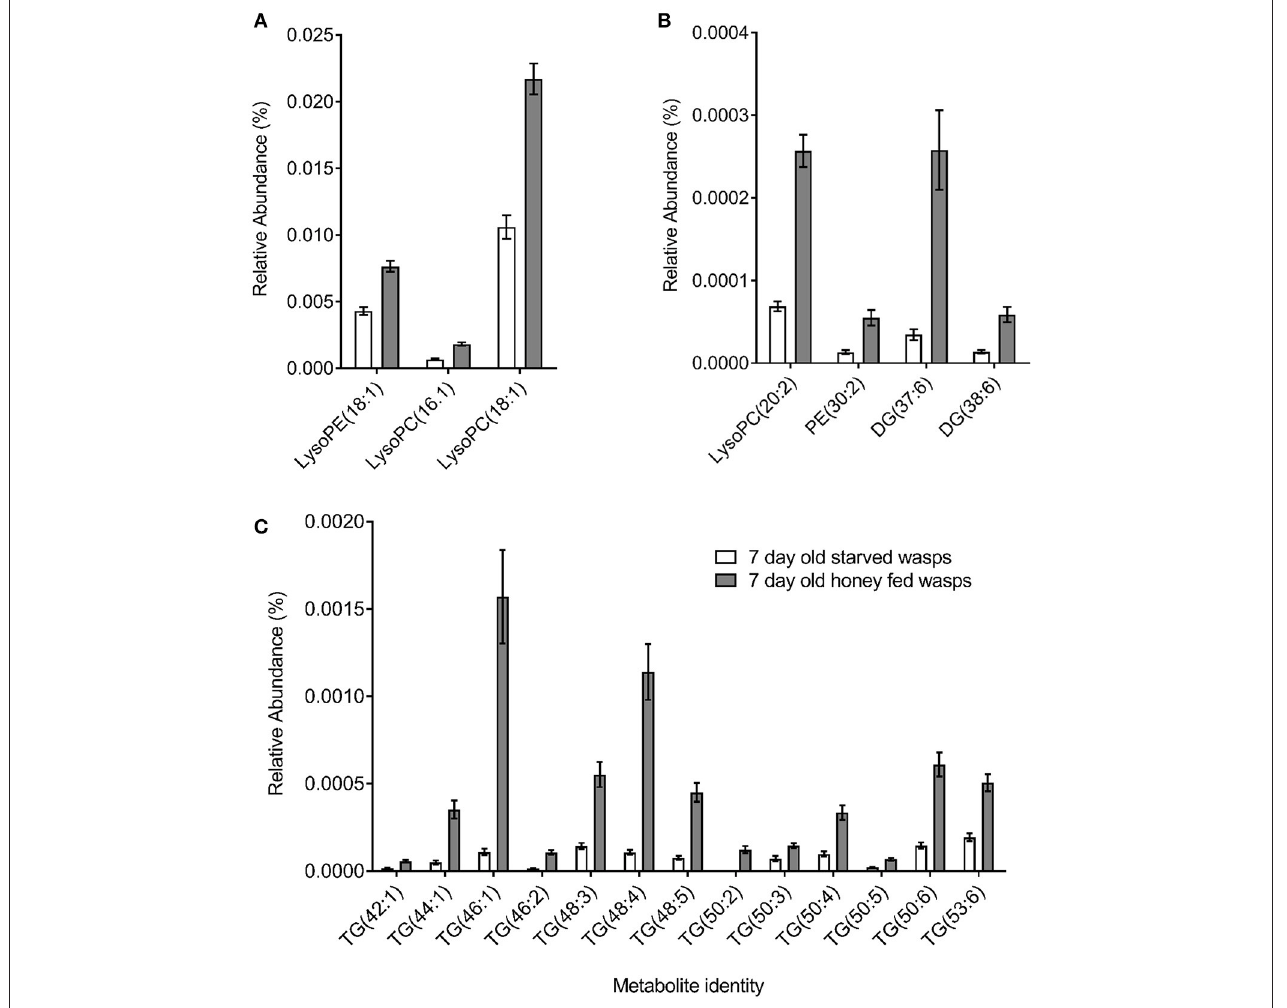
FIGURE 4 | Non-polar metabolite differences between 7-day old starved and 7-day old honey-fed G. legneri (A) lysophospholipids (B) lysophospholipids and (C) glycerolipids. PE, phosphoethanolamine; PC, phosphatidylcholine; DG, diglyceride; TG, triglyceride. The displayed values consist of the mean normalised metabolite area, error bars show 1 standard error. Honey-fed wasps (PC1 = 37.1%, PC2 = 16.2%, PC 3 = 5.86%, R2X =